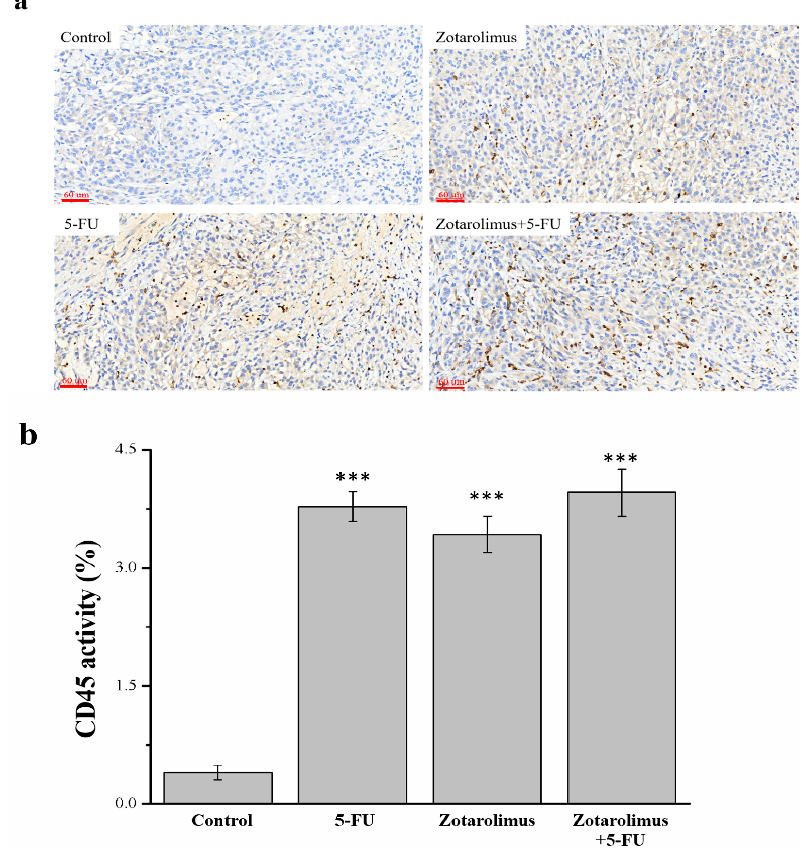
Figure A7. Immunohistochemical expression of ( a ) CD45 and a comparison of the expression levels of ( b ) CD45 in the A549 tumor masses from BALB/cByJNarl in control mice and mice given different treatments, including 5-FU (100 mg/kg/week), zotarolimus (2 mg/kg/day), and zotarolimus (2 mg/kg/day) combined with 5-FU (100 mg/kg/week). All data are presented as mean ± standard deviation, n = 7 per group. *** p < 0.001 compared with the control group. Scale bars = 60 µm.